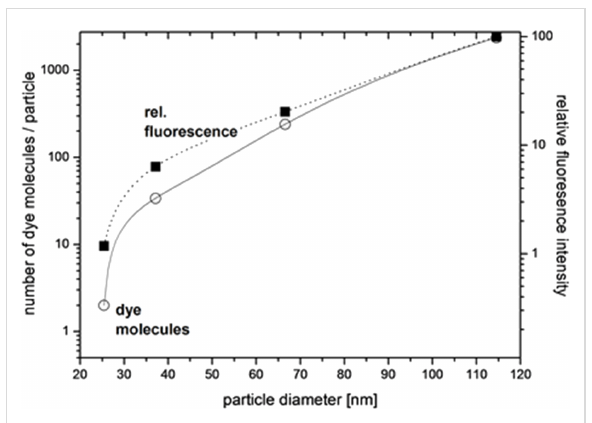
Figure 3: Calculated number of dye molecules per silica particle as a function of size (filled square) and relative fluorescence intensity (open circles) as a function of the particle size. The ratio of fluorophore per particle was calculated based on the concentration of nanoparticles and the molar content of dye assuming a dye immobilisation yield of 100%. Dye-labelled particles show a volume-dependent increase in fluorescence intensity. The amount of immobilised dye can (statisti- cally) be controlled between two (FD25) and several hundred (FD80) dye molecules per particle, just by addition of dye during each regrowth step.